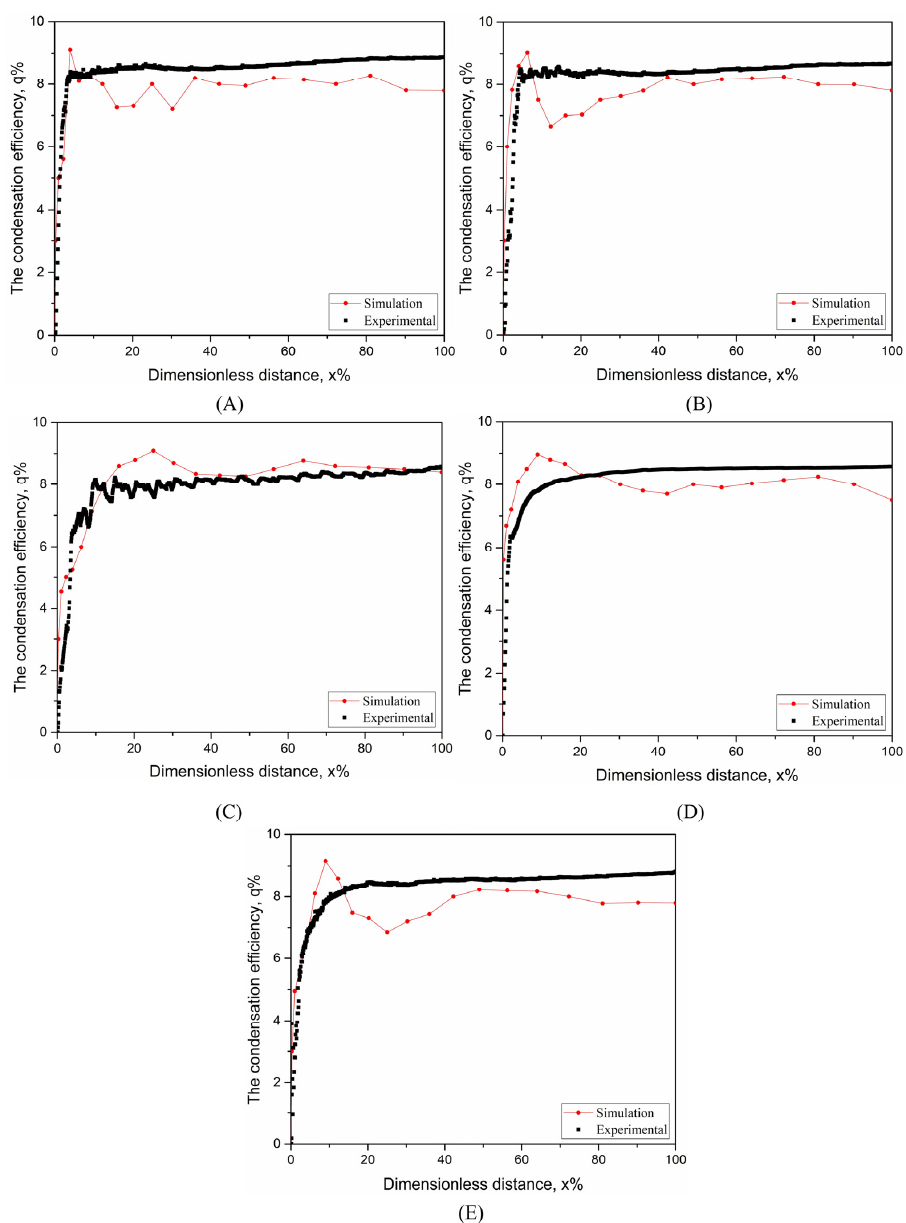
Figure 6. Experimental and simulation results of the condensation efficiency of droplets with initial diameters of ( A ) 1.195 mm, ( B ) 1.523 mm, ( C ) 4.01 mm, ( D ) 5.013 mm, and ( E ) 5.459 mm in direct contact with steam. After the rapid condensation stage, the e ff ect of droplet diameter on the condensation